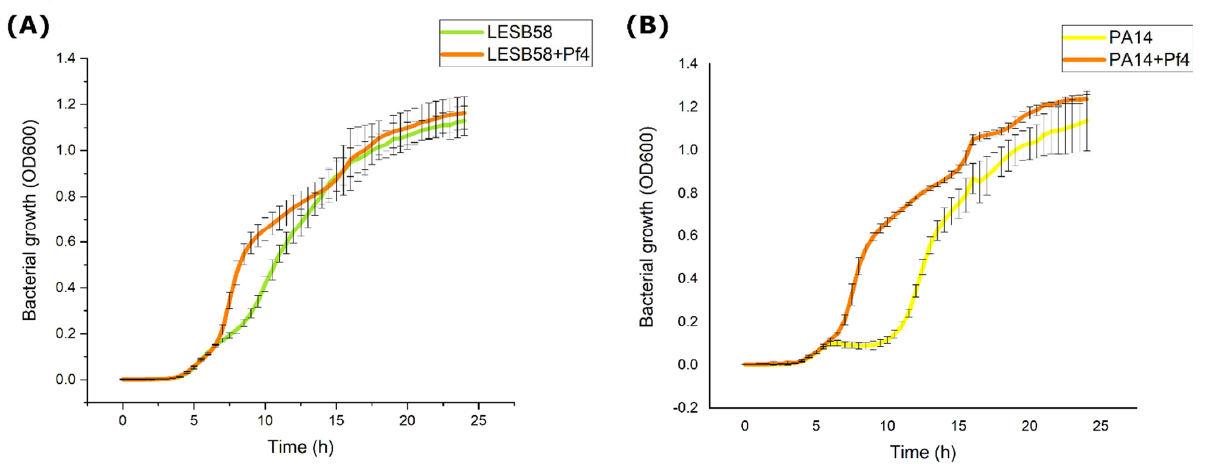
Figure 4. Growth of uninfected and Pf4 ‐ infected LESB58 ( A ) and PA14 ( B ) strains, monitored every 30 min during 24 h, and expressed as OD600 (average +